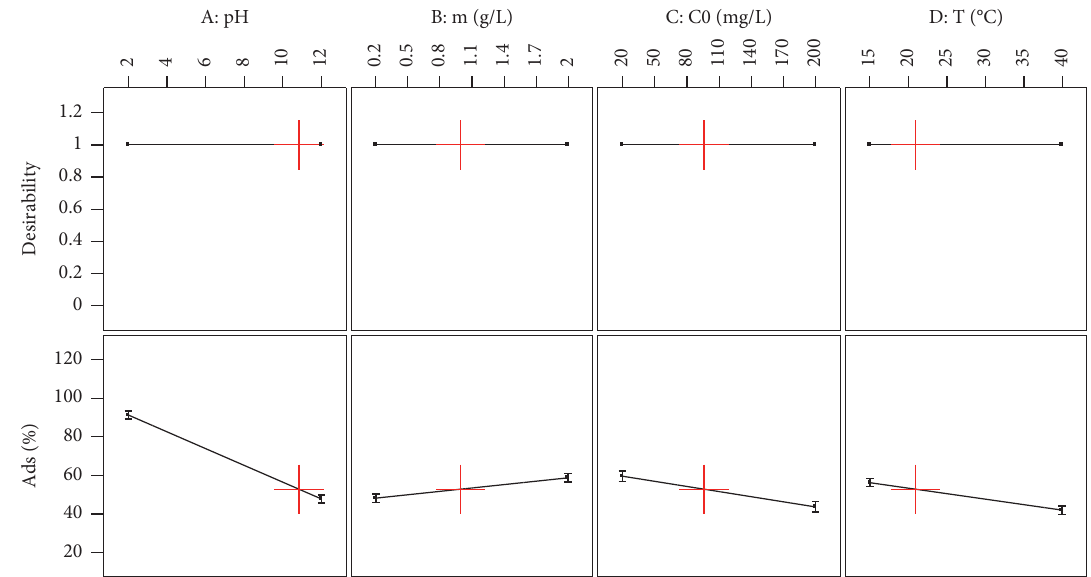
Figure 7: Prediction profile plot with adjusted desirability and factor values.